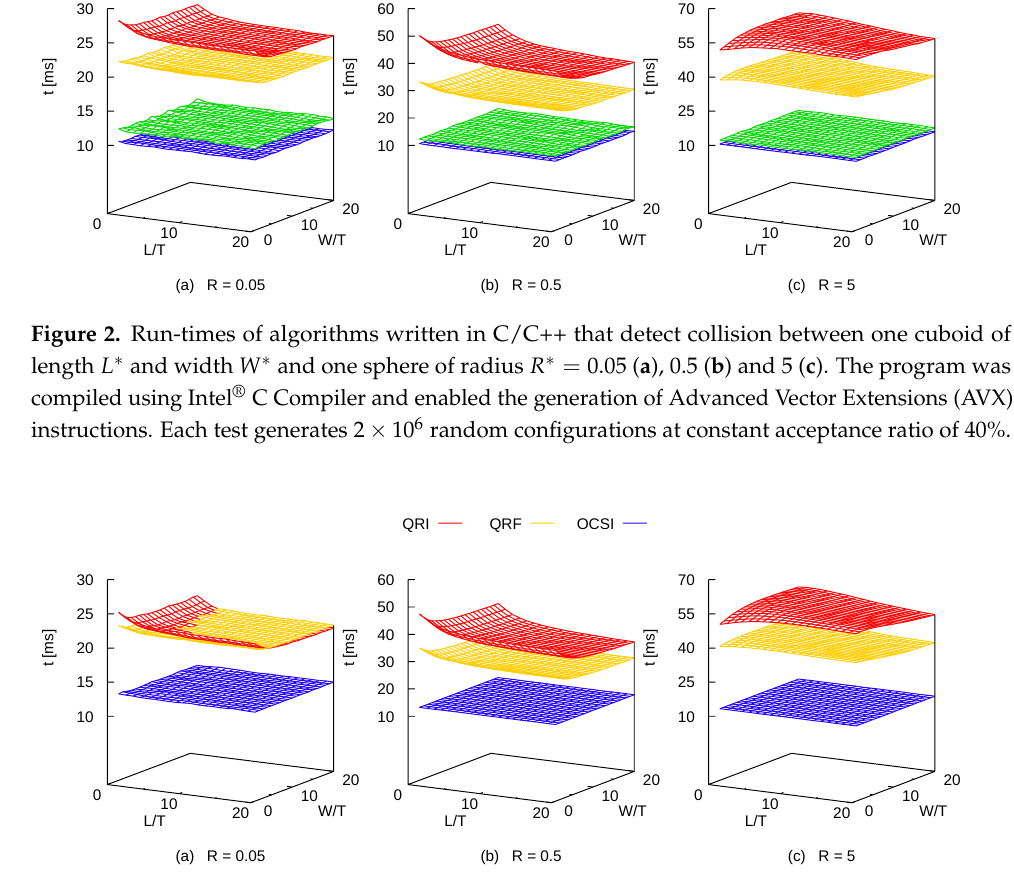
Figure 3. Run-times of algorithms written in F90 that detect collision between one cuboid of length L ∗ and width W ∗ and one sphere of radius R ∗ = 0.05 ( a ), 0.5 ( b ) and 5 ( c ). The program was compiled using Intel ® Fortran Compiler and enabled the generation of AVX instructions. Each test generates 2 10 6 random configurations at constant acceptance ratio of ×